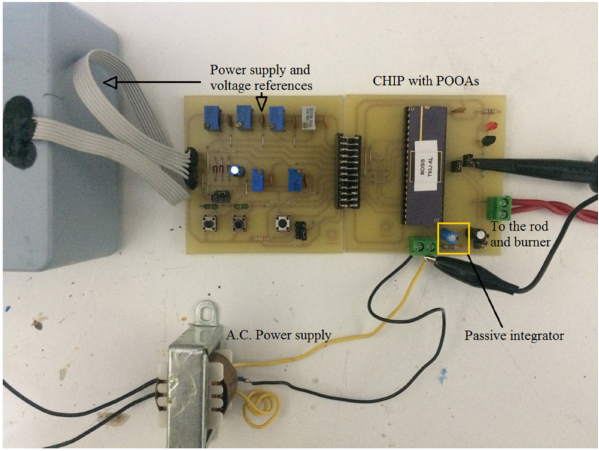
Figure 12. Picture of the entire flame detection sensor. The main parts of the system are clearly